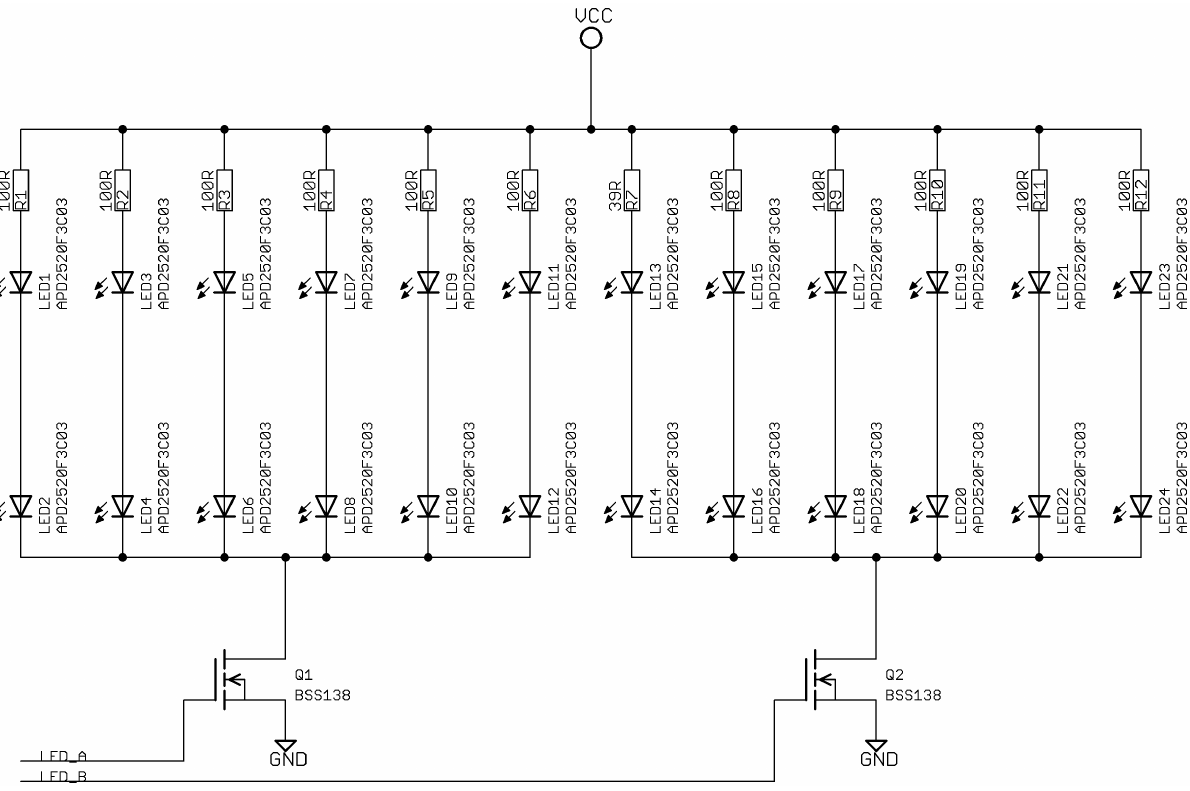
Figure A2. Schematic diagram of the LEDs mounted in the tunnels. When Q1 is activated, then the input LEDs emit while when Q2 is activated the output LEDs emit. By sampling at 1KHz, each